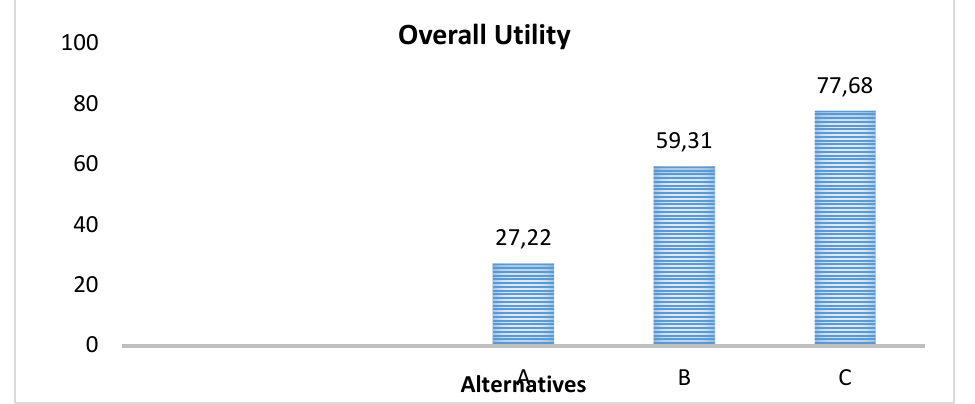
Figure 11: Overall Utility Ranking for all three